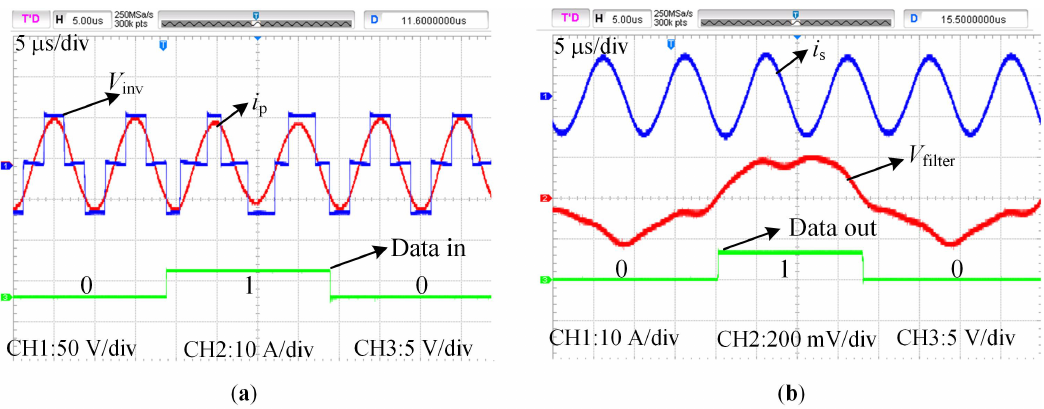
Figure 16. Experimental results of forward communication. ( a ) Measured waveforms of V inv and i p when the transmitted bits are “010” (Data in) under ϕ p = 90 ◦ . ( b ) Measured waveforms of i s , V filter and received data (Data out).